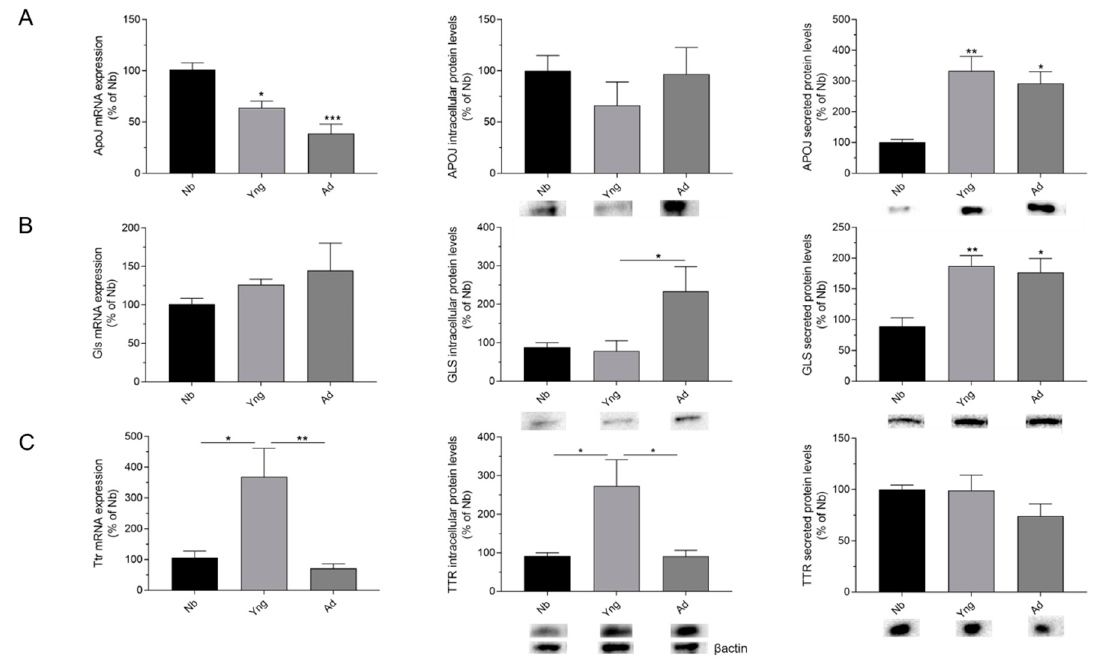
Figure 1. Effects of age on the expression of apolipoprotein J (APOJ), gelsolin (GLS), and transthyretin (TTR) in the choroid plexus (CP). mRNA expression, intracellular protein and secreted protein levels of APOJ ( A ), GLS ( B ), and TTR ( C ) in CP explants and conditioned media of newborn (Nb), young (Yng), and adult (Ad) rats was analyzed by real time RT-PCR and Western blot, respectively. Bar graphs represent mean ± SEM (N ≥ 3; * p < 0.05, ** p < 0.01, *** p < 0.001; one-way ANOVA followed by Bonferroni’s post hoc test).